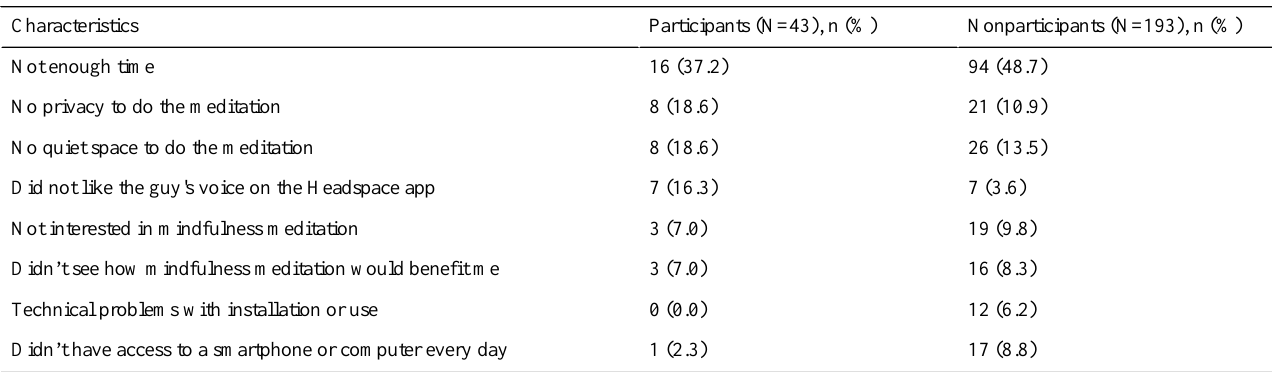
Table 3. Barriers to Headspace